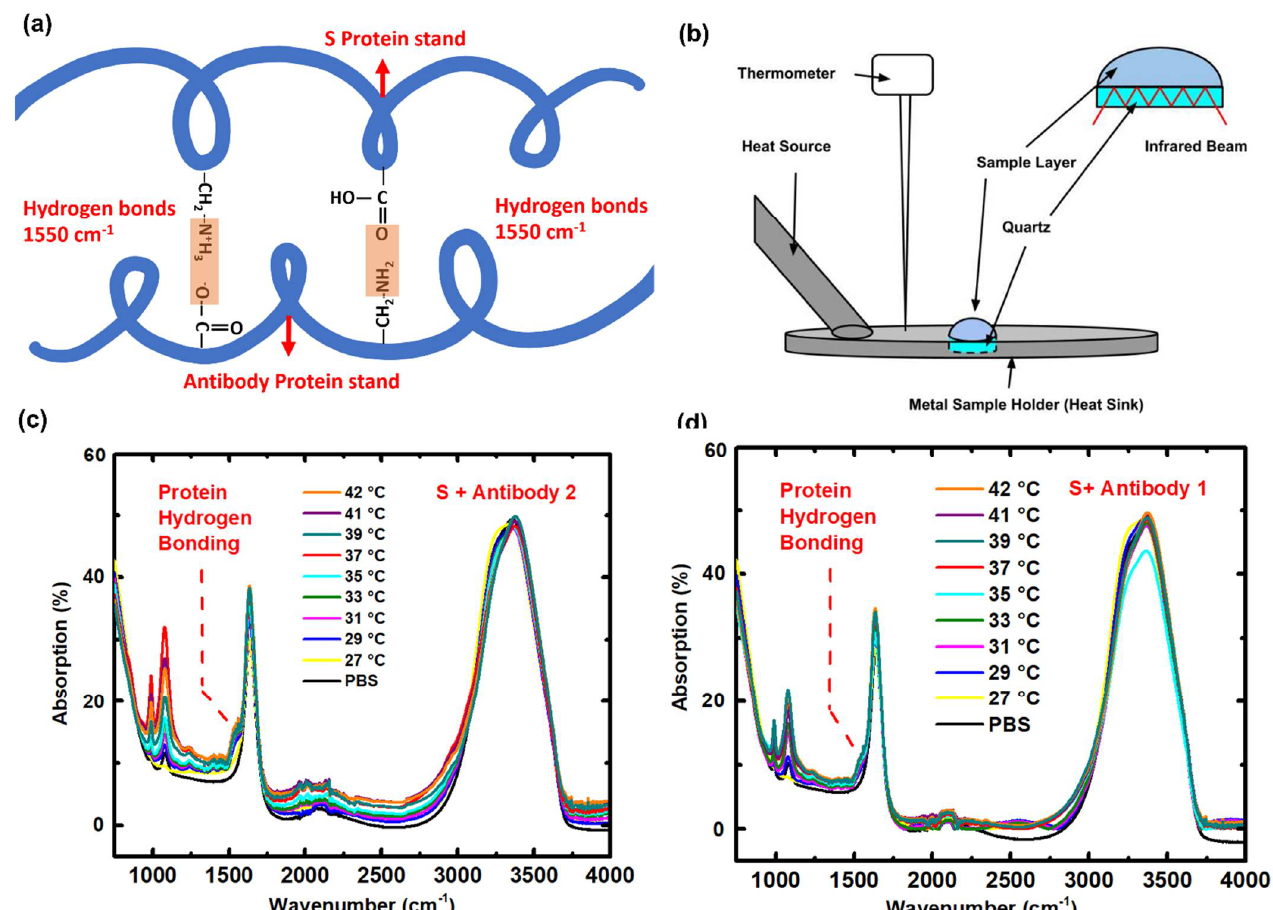
Figure 1. ( a ) Schematic illustration of the hydrogen bonding between carboxyl and amino groups of the protein strands, representing a typical intermolecular binding for the secondary structure of proteins. ( b ) For the FTIR apparatus, the ATR model has been adopted to improve the signal noise ratio, which offers 0.1% error margin in the absorption measurement and 0.5 cm − 1 along the wavenumber scan. To facilitate the possible temperature variation, an electric heating element and a thermometer were attached to the metallic plate of the ATR assembly, which also acts as an ideal heat sink. Samples of antibodies and spike proteins were mixed together and underwent FTIR spectroscopic examination conditioned by variable temperatures. ( c ) The FTIR scan of the sample mixture of SARS-CoV-2 spike protein/SARS-CoV-2 antibody (S + Antibody 2) in PBS solution. Comparing the FTIR signal of the PBS solvent, it indicates that 1550 cm − 1 was the only absorption band exclusively associated with the proteins but not overshadowed by the PBS solvent. ( d ) The same FTIR scan of the sample mixture of SARS-CoV-2 spike protein/SARS-CoV-1 antibody (S + Antibody 1) in PBS solution.